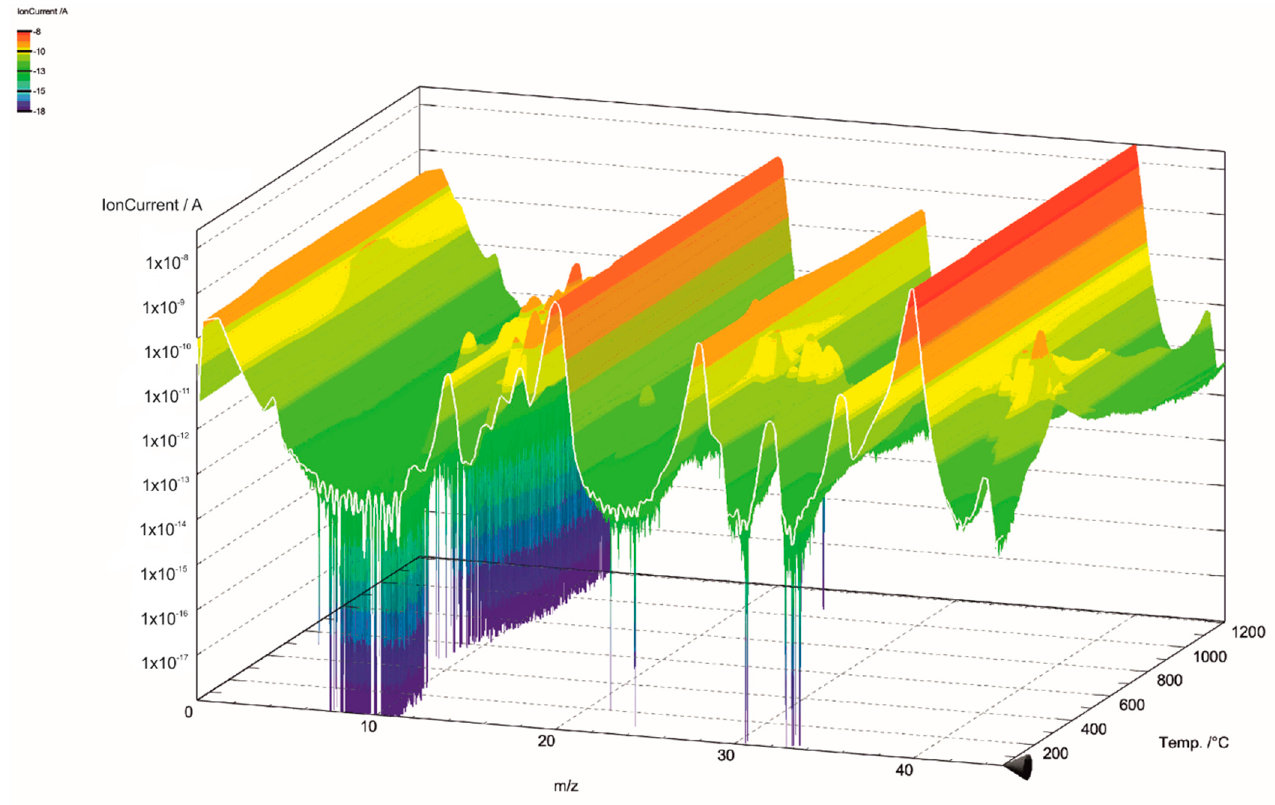
Figure 6. Mass spectra of lignin pyrolysis product gas in the m / z range of 0–45. Minerals 2021 , 11 , x FOR PEER REVIEW